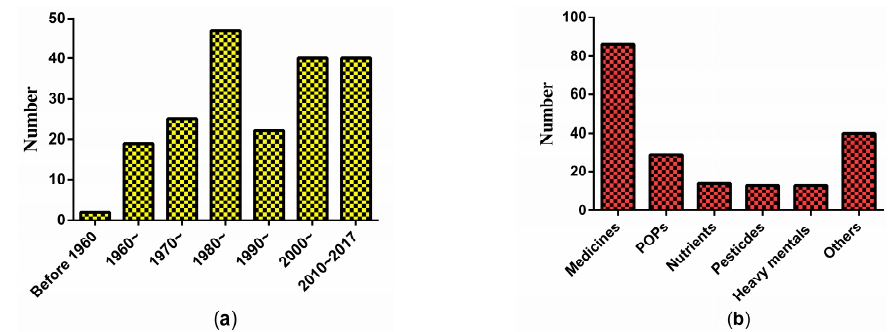
Figure 3. The distribution of xenobiotics studied related to glucose metabolism in testes: ( a ) by publication year; ( b ) types.